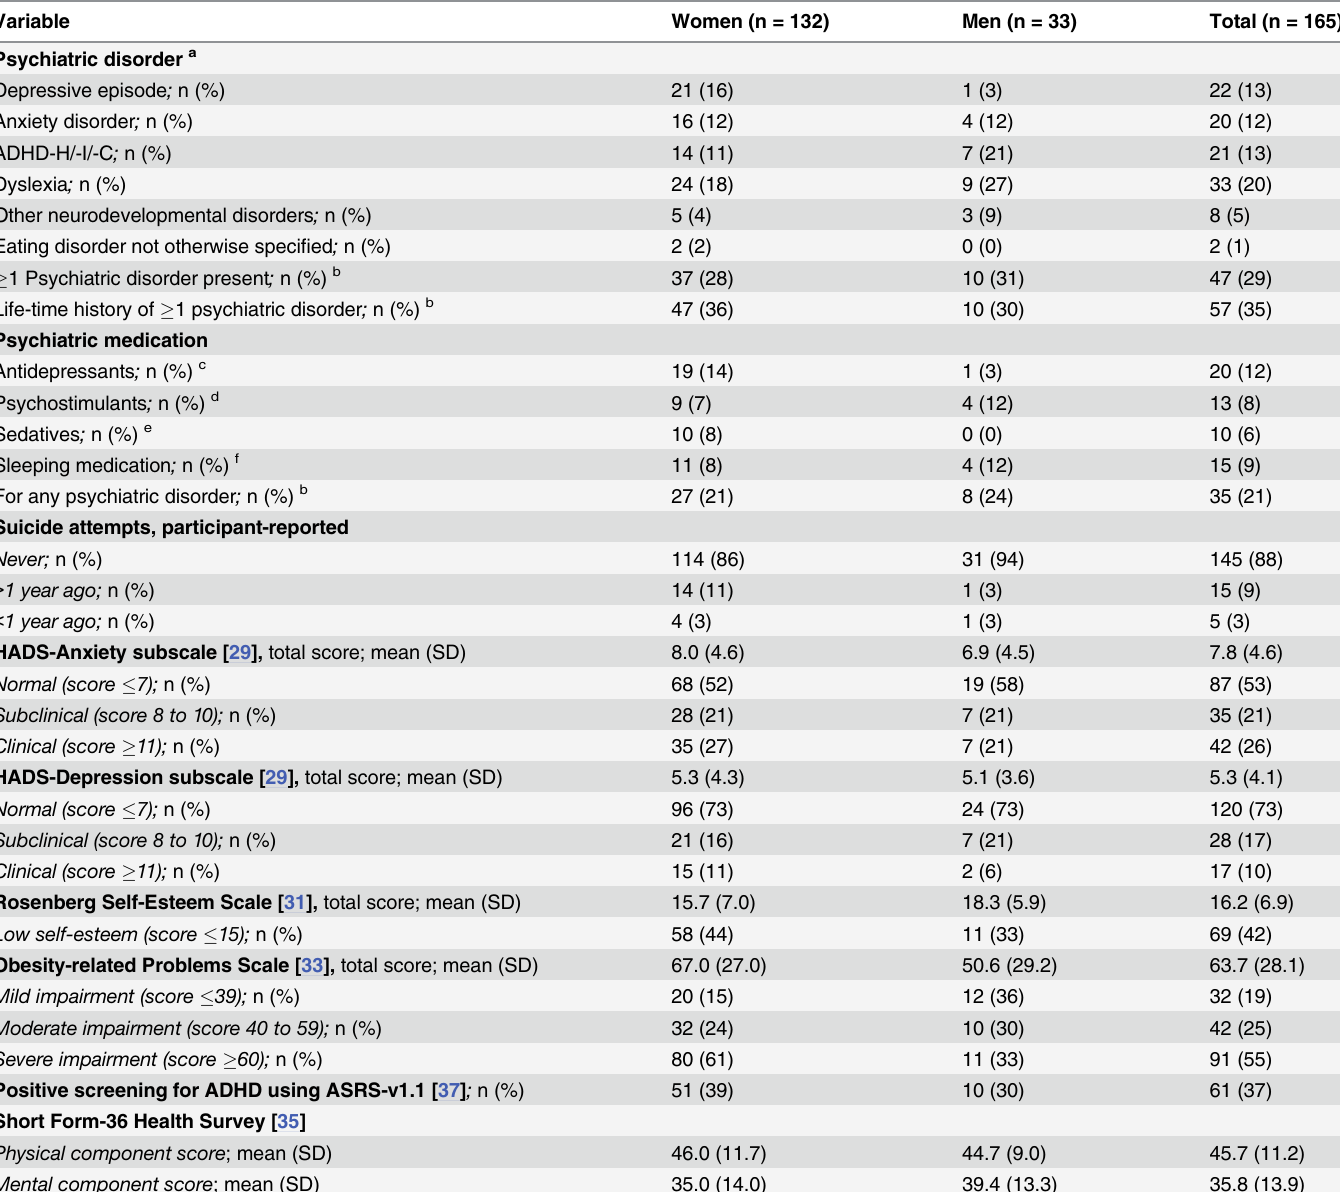
Table 3. Psychiatric disorders, psychiatric medication, suicide attempts, mental health and health-related quality of life in n = 165 treatment-seek- ing young adults (16 – 25 y) with obesity.